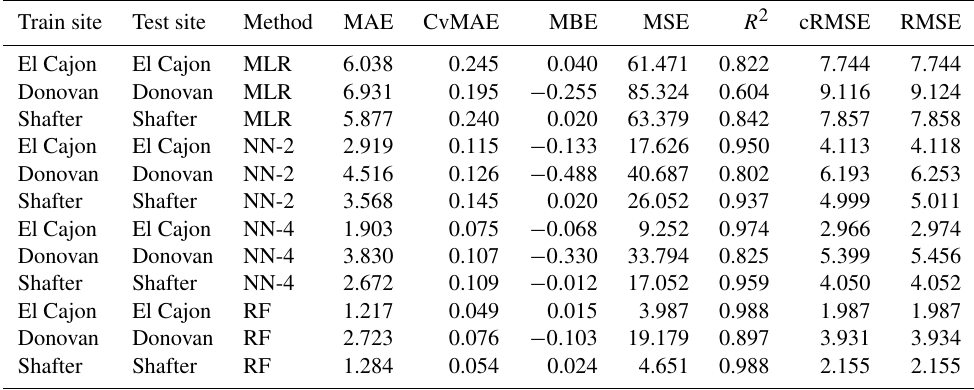
Table C4. Level 0 test results for O 3 .